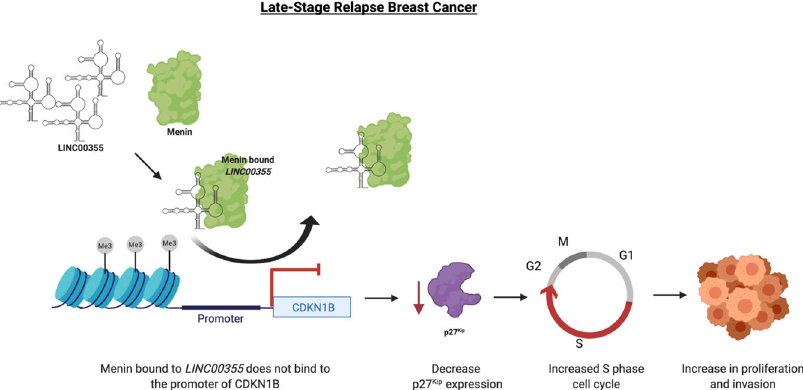
Fig. 6 Model showing regulation of LINC00355. MENIN binding to LINC00355 changes its occupancy at the CDKN1B promoter to decrease CDKN1B gene expression and p27 Kip protein levels. This alters S phase cell cycle checkpoint that leads to increased cellular proliferation and contributing to phenotypes of late-stage relapse breast cancer. Created with Biorender.com.